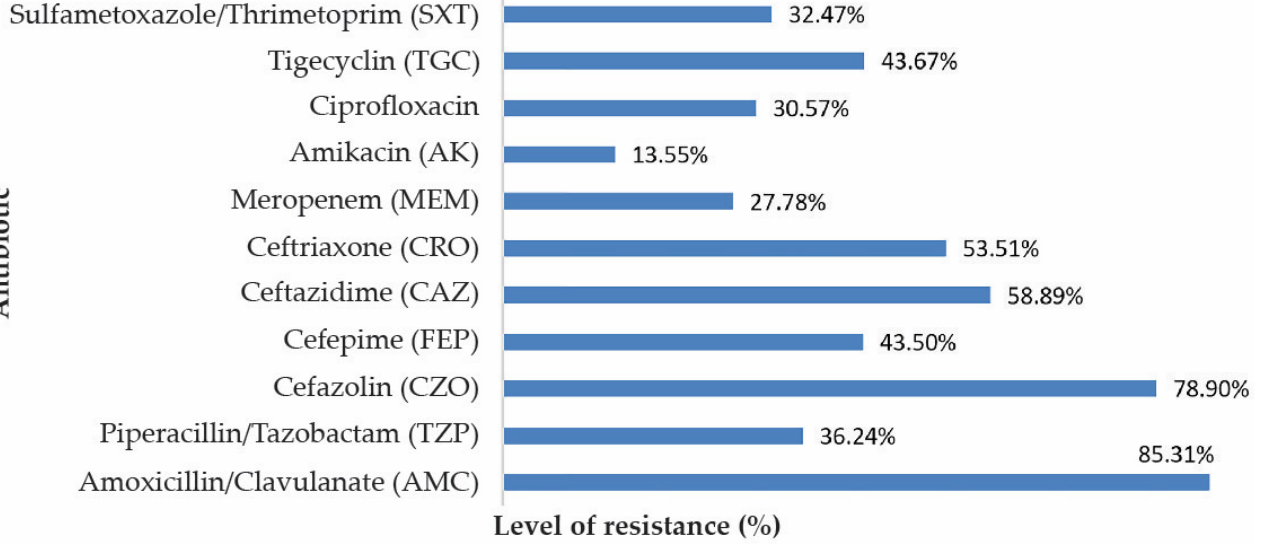
Figure 4. Resistance to antimicrobial substances of the isolated Klebsiella strains.